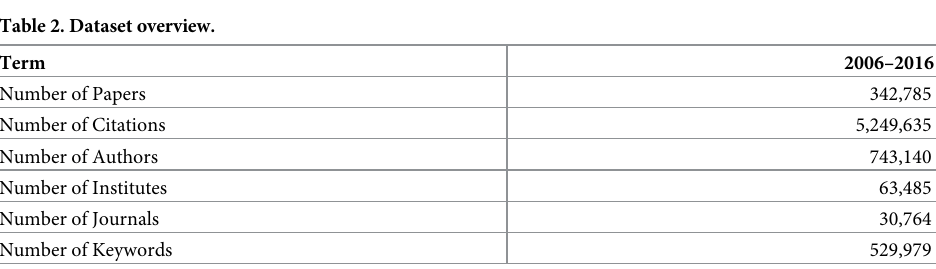
Table 2. Dataset